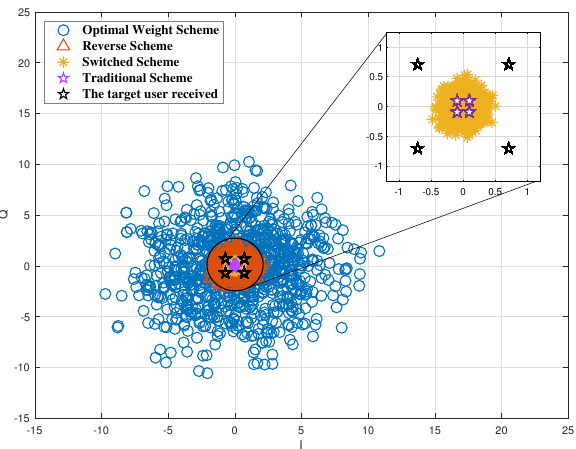
Figure 3. The constellation diagram in the direction of the